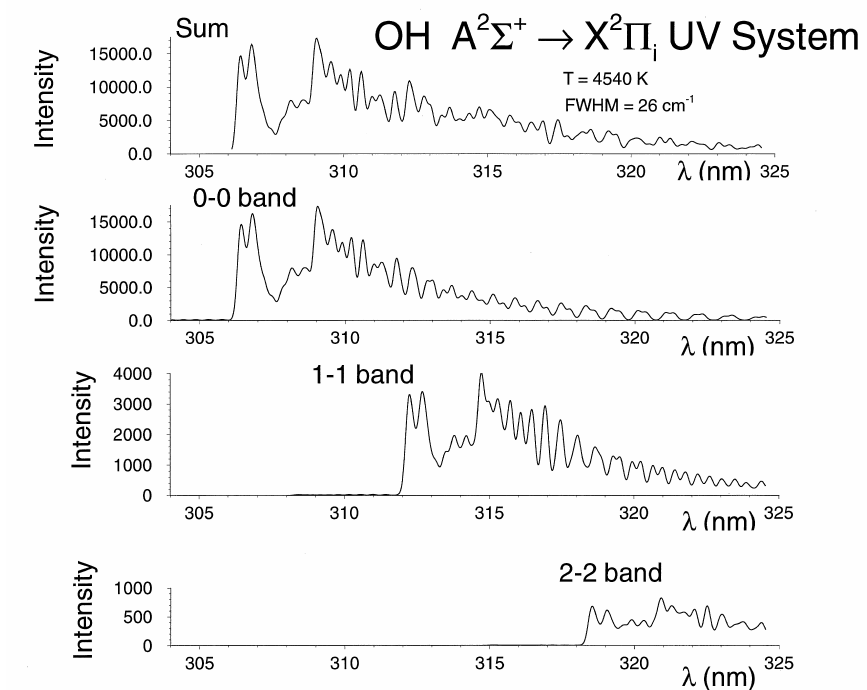
Figure 9. Comparisons of measured and recorded laser-plasma emission spectroscopy